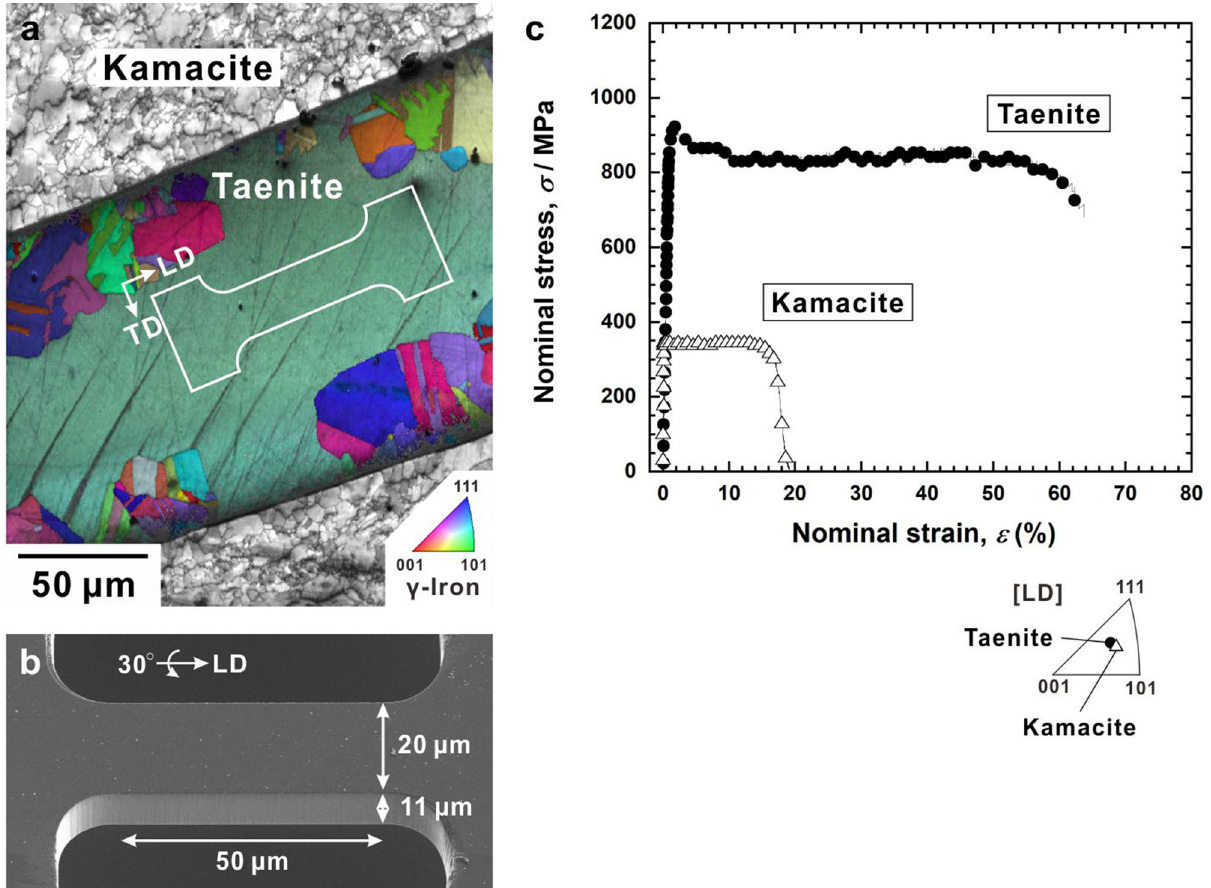
Figure 2. Preparation of micro-tensile specimen and obtained stress–strain behaviours. ( a ) Inverse pole figure map overlaid by schematic illustration of micro-tensile specimen in taenite. LD and TD denote the loading and transverse directions, respectively. ( b ) Scanning electron microscopy image showing the shape and dimensions of the micro-tensile specimen. ( c ) Nominal stress–strain, σ – ε , curves for the taenite and kamacite specimens. The stereographic triangle shows the LDs in the taenite and kamacite